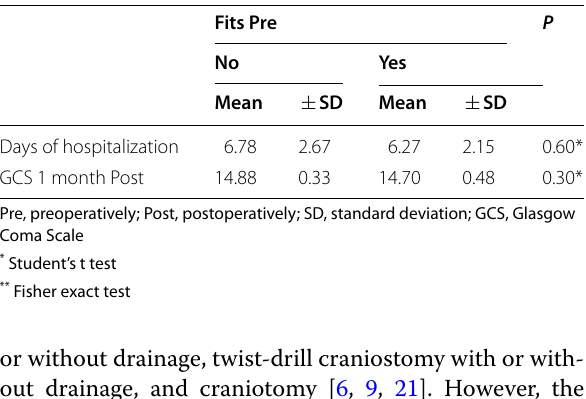
Table 12 Cases with and without preoperative convulsions compared regarding final study outcomes